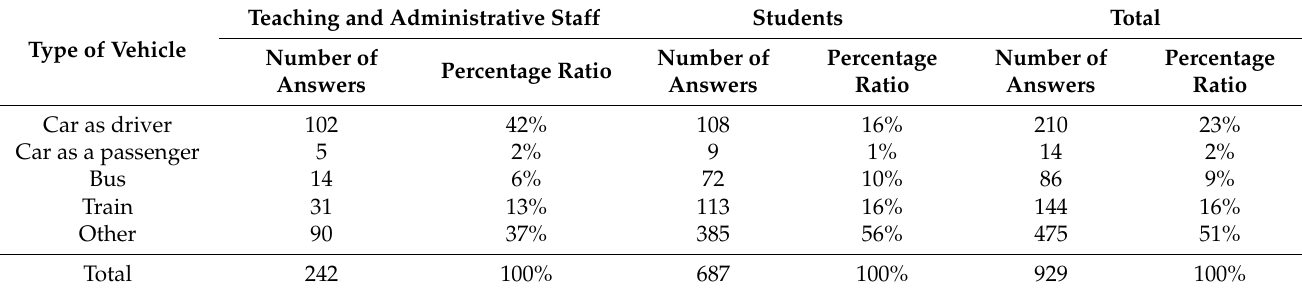
Table 9. Main means of transport used on the way home to university in 2020.